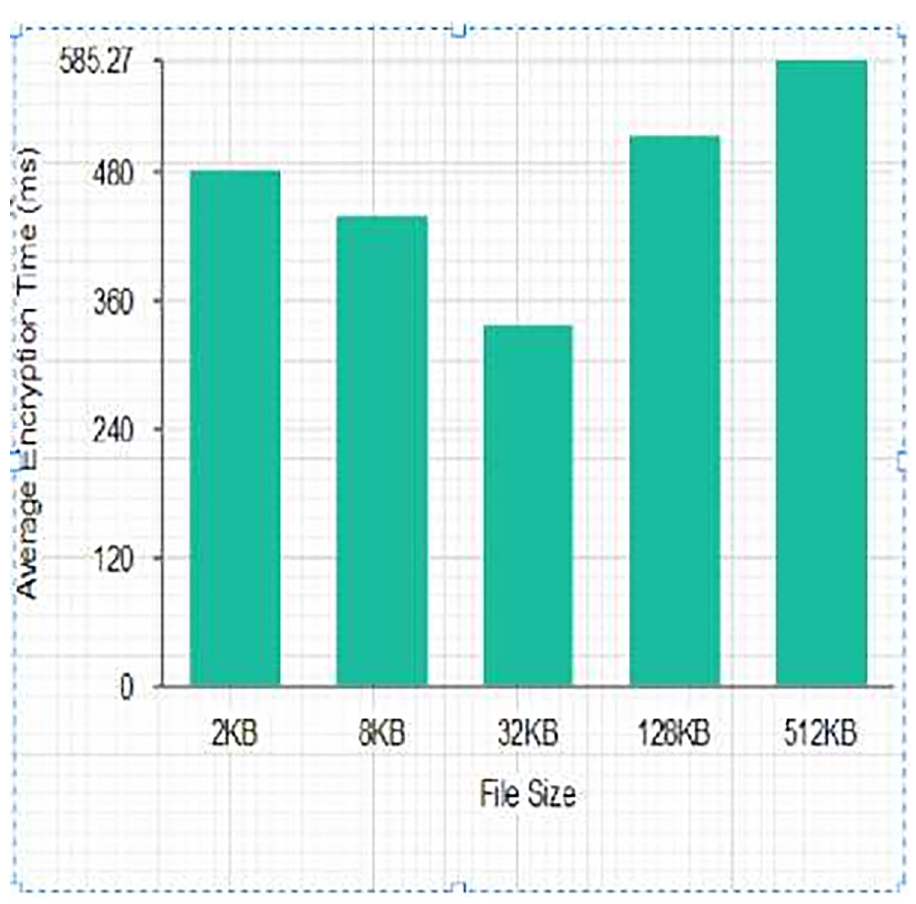
Fig 14. Average Encryption Time